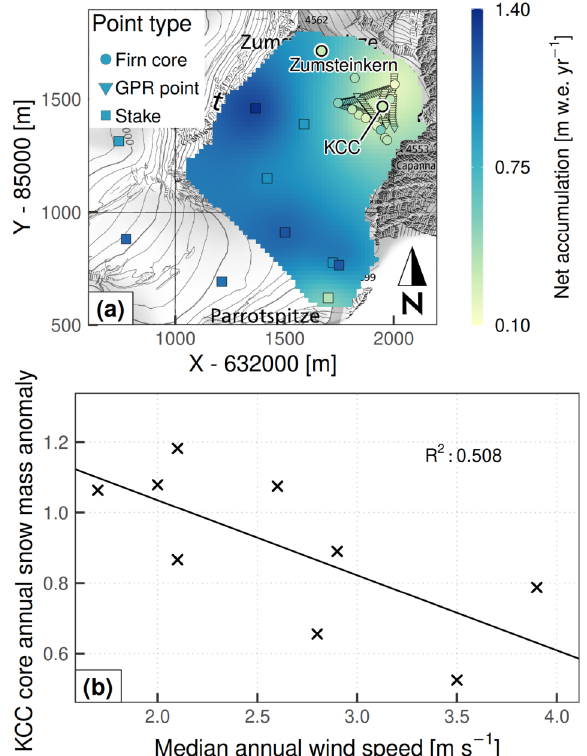
Figure 3. (a) Long-term net annual accumulation climatology at CG, serving as the spatial component for the distributed accumu- lation model. Dense point sequences in the northeast were derived from GPR profiles. x and y are metric CH1903/LV03 coordinates. Topographic map source: Federal Office of Topography swisstopo. (b) Linear fit of annual snow mass anomaly at core KCC versus median annual wind speed at the CM